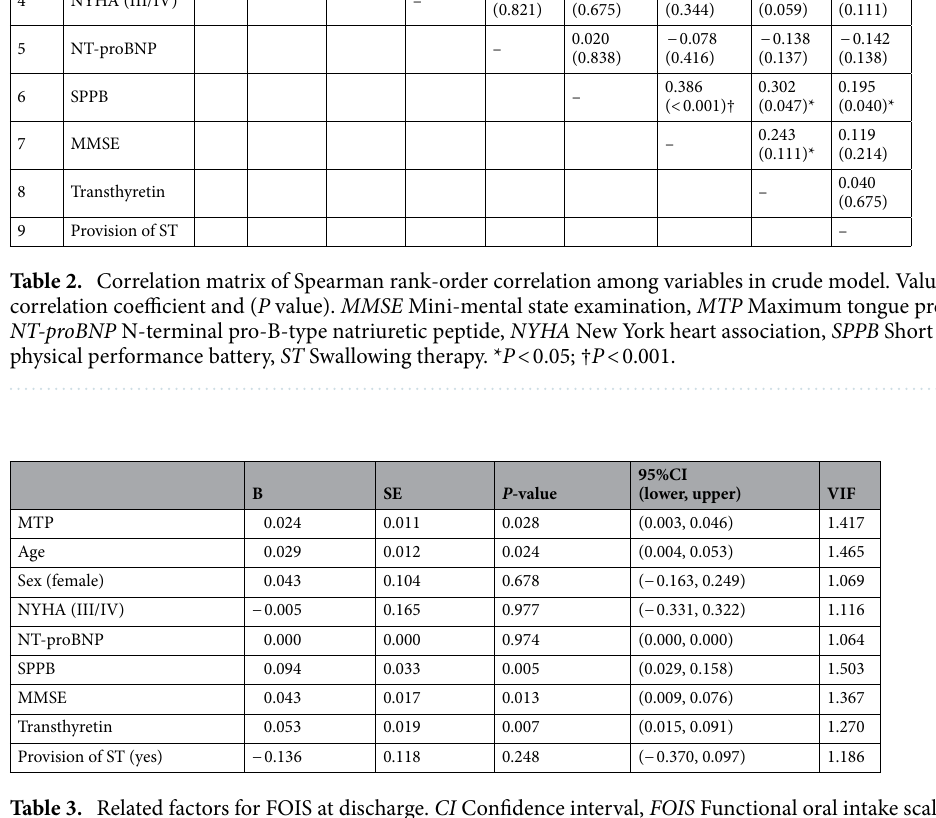
Table 3. Related factors for FOIS at discharge. CI Confidence interval, FOIS Functional oral intake scale, MMSE Mini-mental state examination, MTP Maximum tongue pressure, NT-proBNP N-terminal pro-B-type